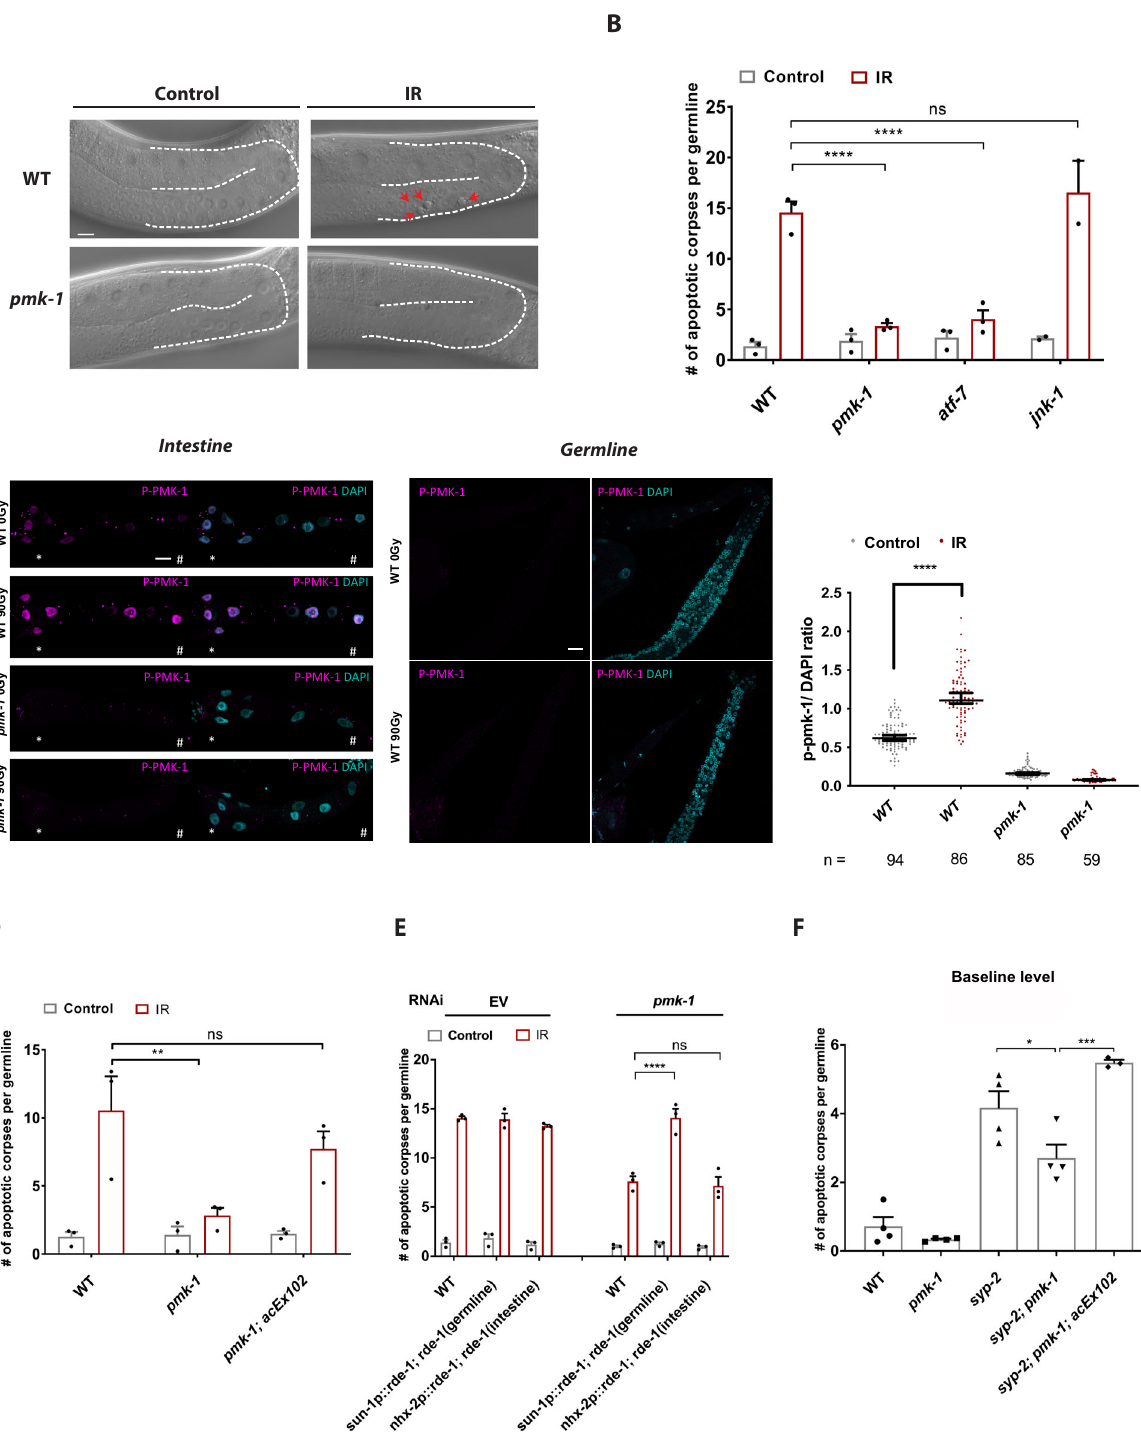
next performed a tissue-speci fi c RNA interference (RNAi) experi- ment. To this end, we employed rde-1 mutant strains whose RNAi de fi ciency is rescued by cell type-speci fi c expression of RDE-1 expressed either exclusively in the germ cells or the intestine. The promoters of nhx-2 and sun-1 were previously used to drive tissue- speci fi c expression of RDE-1 in the intestine and germline, respectively 33 – 35 . RNAi knockdown of pmk-1 in the intestine, but not in the germline, resulted in a similar reduction of